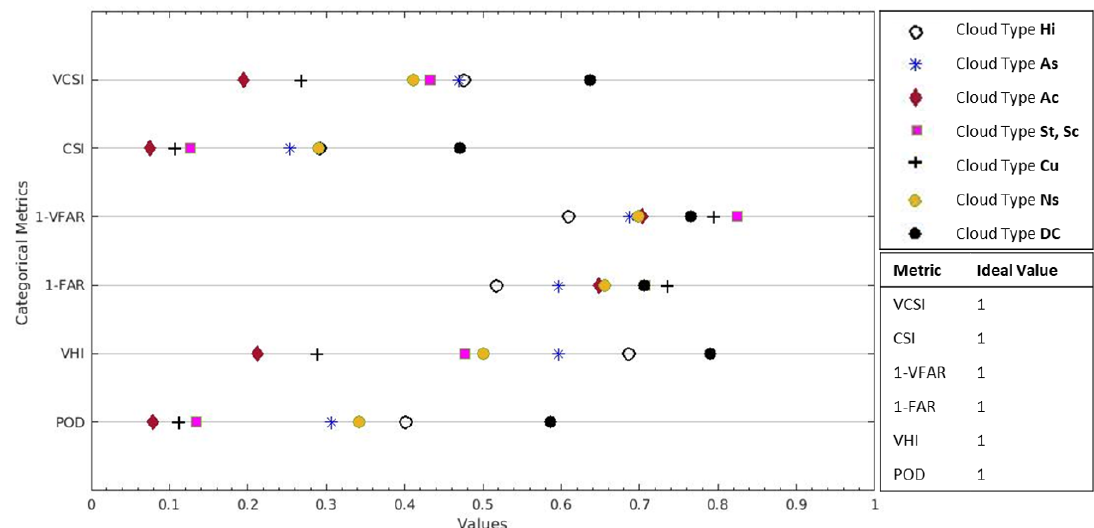
Figure 7. Evaluation of PERSIANN-CCS across the United States for July 2018. Categorical verification metrics: Probability Of Detection (POD), Volumetric Hit Index (VHI), False Alarm Ratio (FAR), Volumetric False Alarm Ratio (VFAR), Critical Success Index (VCSI) and Volumetric Critical Success Index (VCSI). MRMS rain rate data is used as a